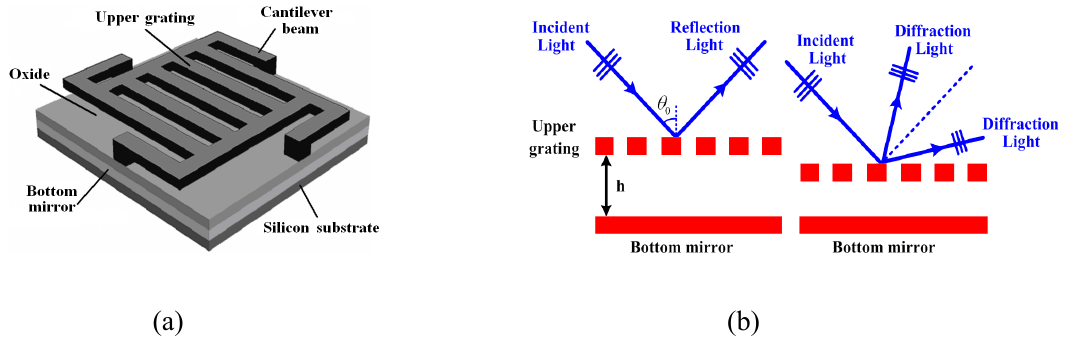
Figure 2. (a) Structure of a single GLM. (b) Optical model of